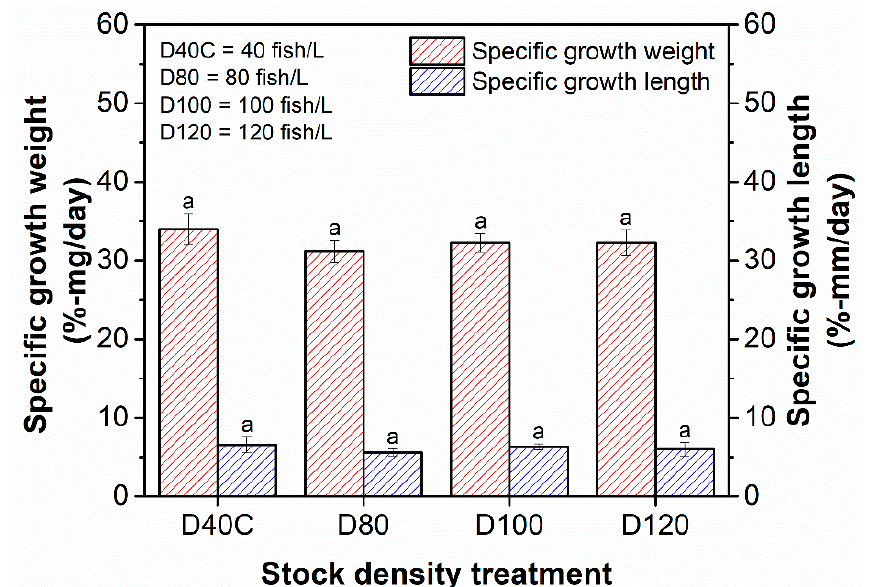
Figure 6. The specific growth rate of weight and length of striped catfish ( Pangasianodon hypophthalmus ) larvae at various stock density treatment levels in exogenous stage, at mean temperature of 27 °C. Vertical bars indicate standard error. Different letters denote significant differences between groups ( p < 0.05).